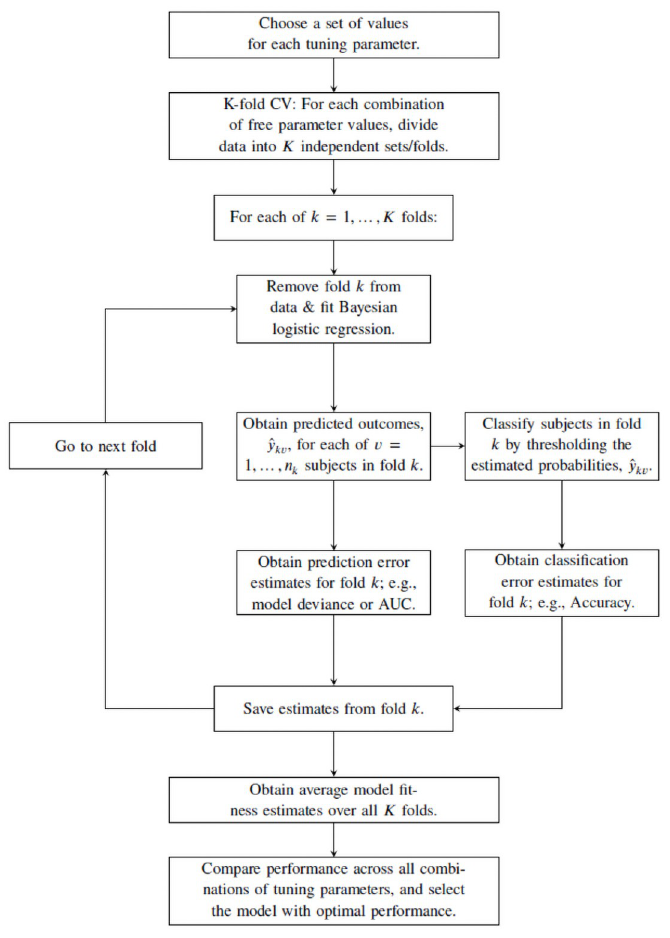
Fig 2. This flowchart describes application of k-fold cross validation employed in this